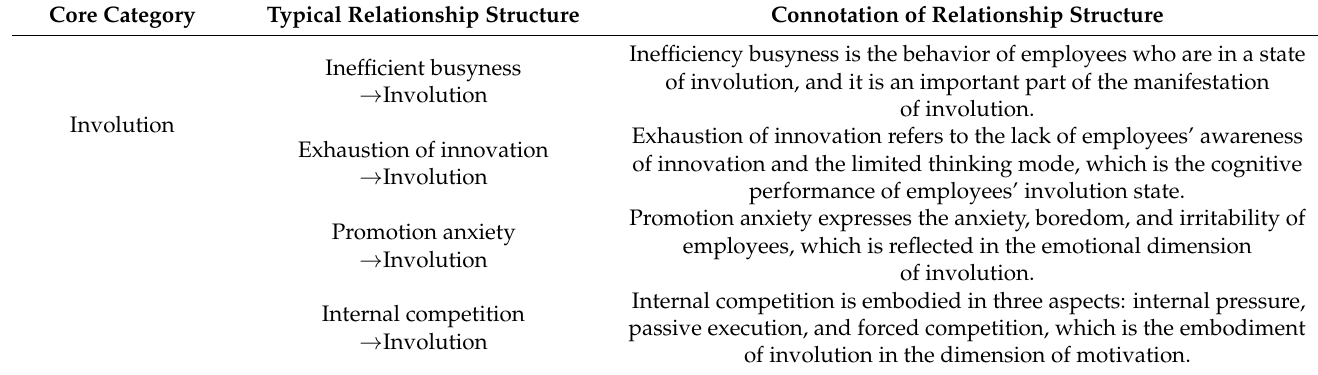
Table 5. Results of selective